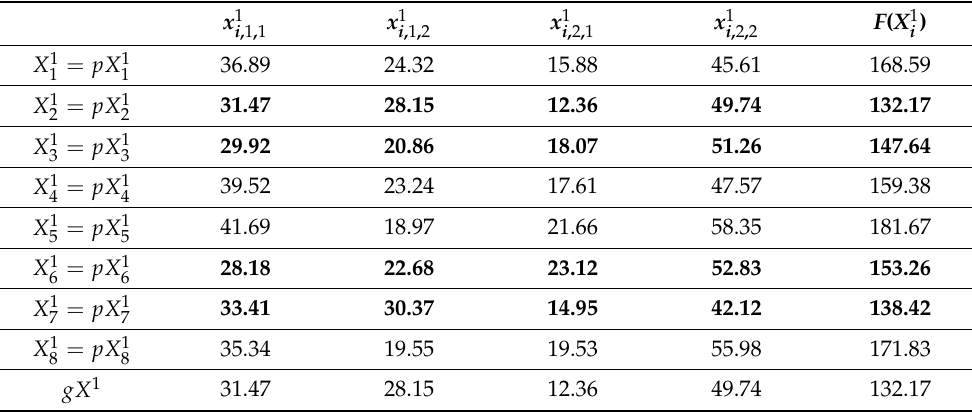
Table 3. Selecting the best solutions among the top 50